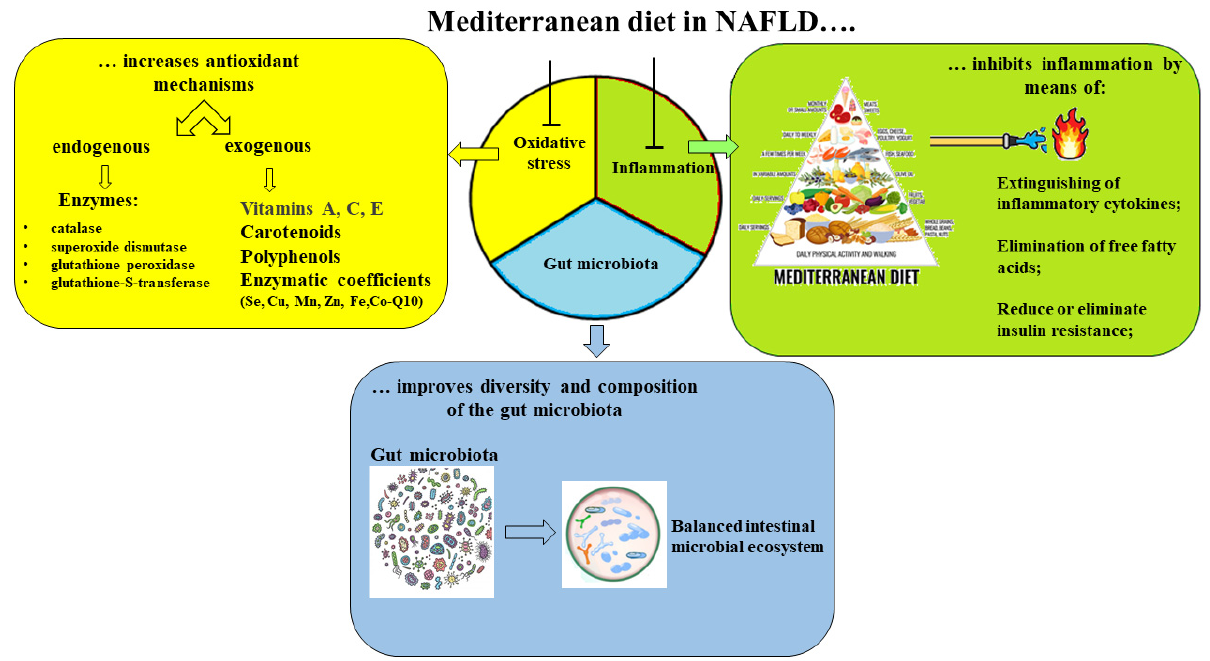
Figure 2. The Mediterranean diet protects from NAFLD. Three key mechanisms are used by the Mediterranean diet to protect against NAFLD: (1) increase antioxidant defenses to combat oxidative stress (portion colored in yellow); (2) inhibit the inflammatory process (portion colored in green); (3) improve the diversity and composition of the intestinal microbiota (portion colored in blue).